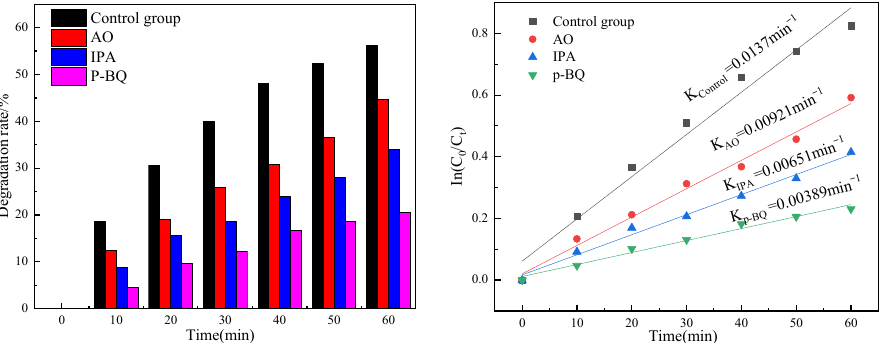
Figure 10. Effect of different trapping agents on photocatalytic OTC at Pt ‐ N co ‐ modified TiO 2 nanotube electrodes and its reaction kinetics.